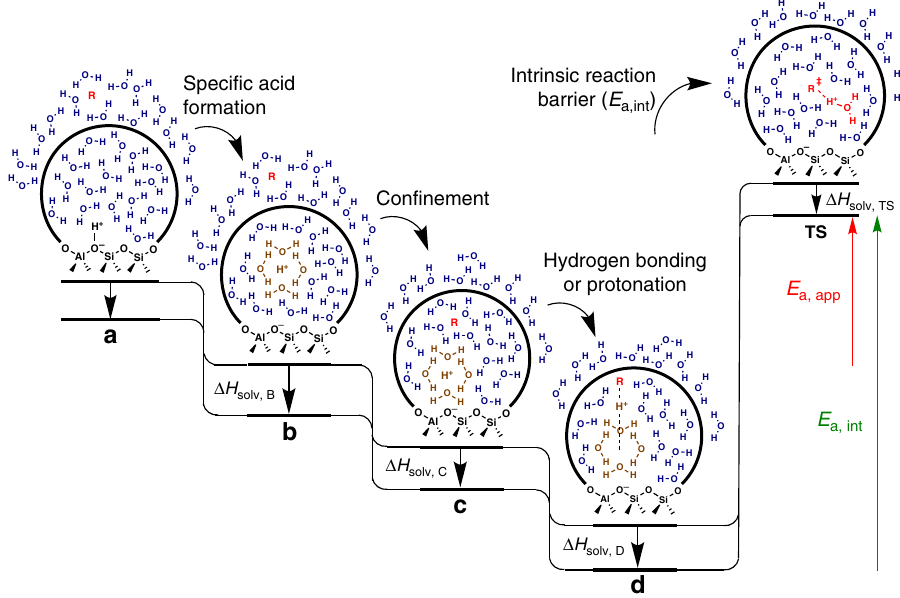
Fig. 1 Reaction coordinate diagram for a typical zeolite catalyzed, aqueous-phase reaction. Initially, the reactant (R) is solvated by the liquid